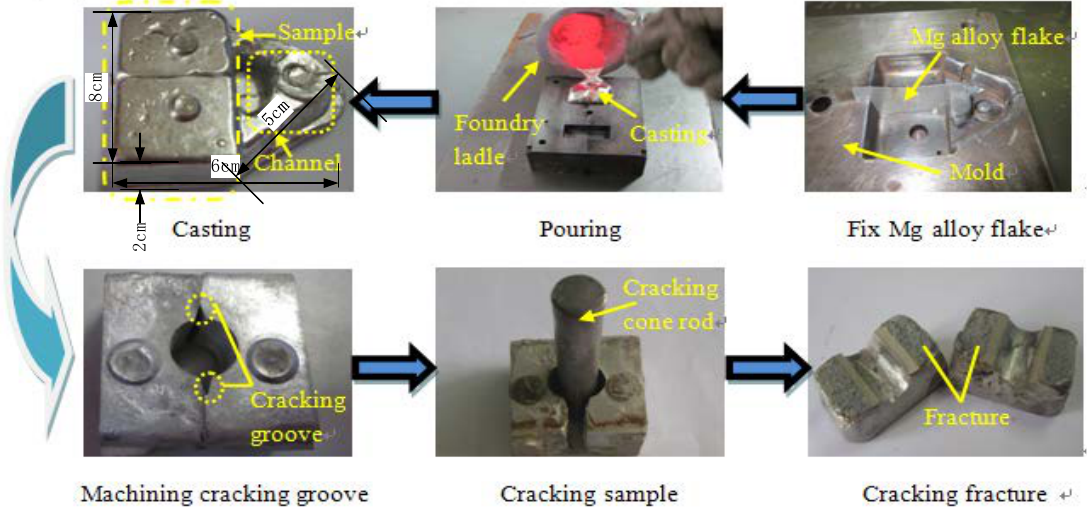
Figure 2. Flow diagram of fracture splitting process.